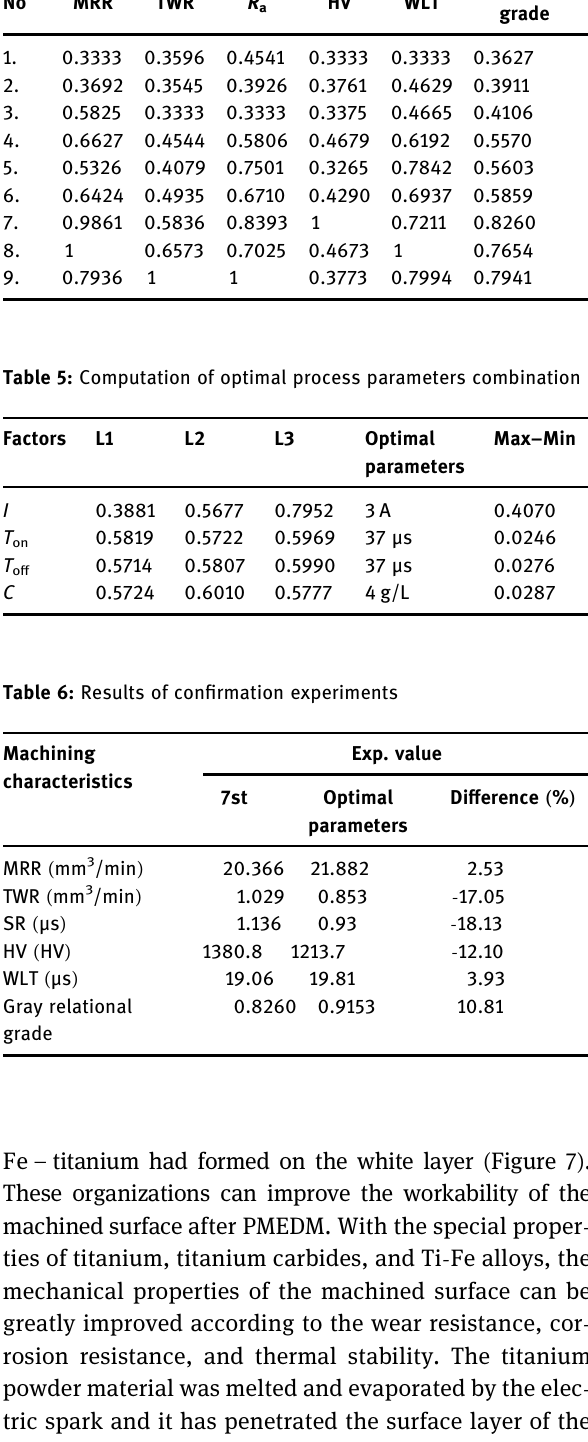
Table 4: Gray relational grade of the present study Trial GC grade Gray gradeNo MRR